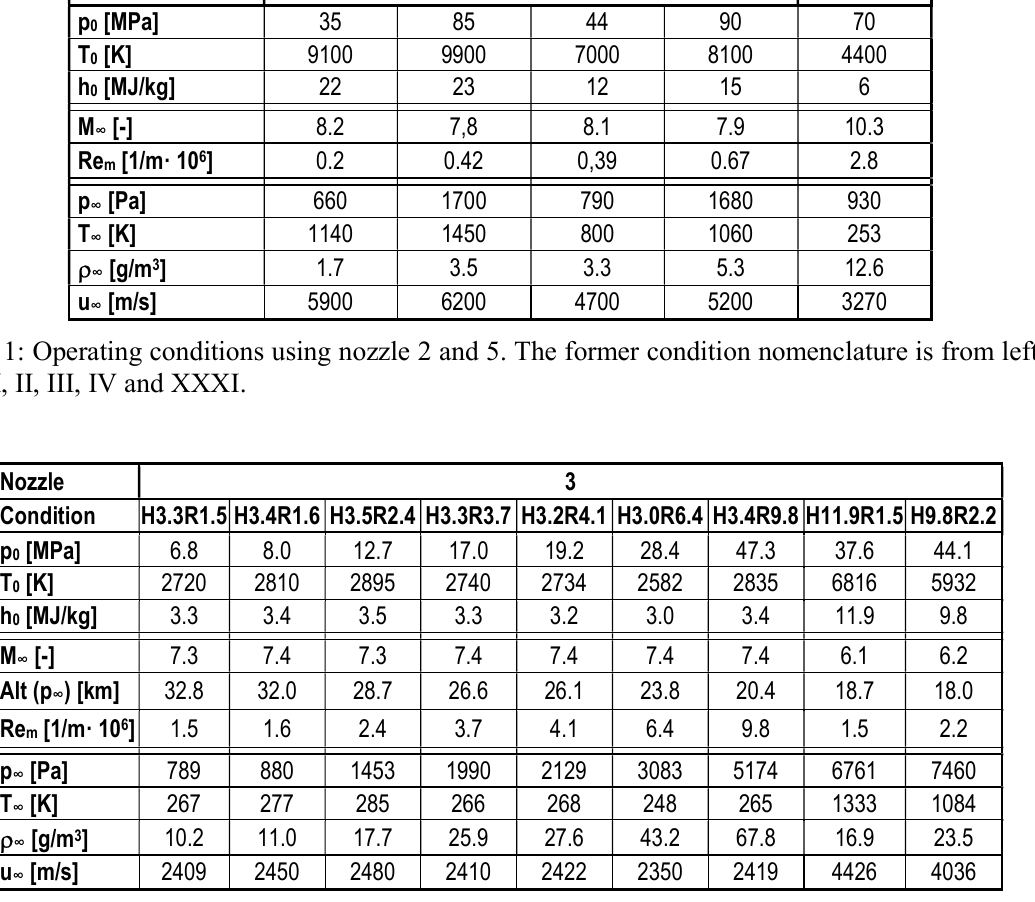
Table 2: Operating conditions using nozzle 3. Former condition nomenclature is XIV for H3.4R1.6, XIII for H3.3R3.7, XV for H3.0R6.4 and XVII for H3.5R2.4.